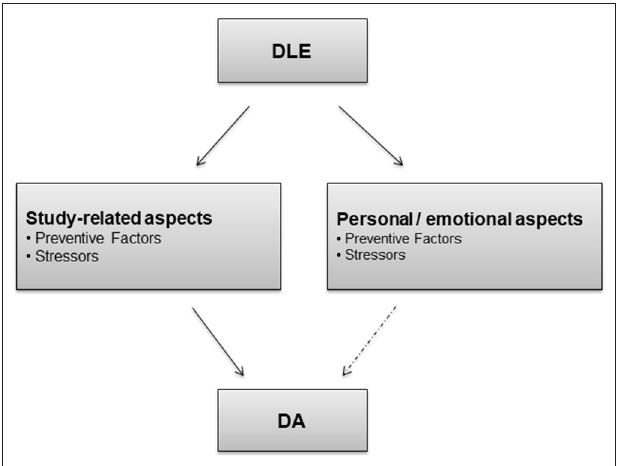
FIGURE 2 | Filled arrows: paths having been described by students in the interviews; dashed arrow: new part to further explore when developing a PDA.